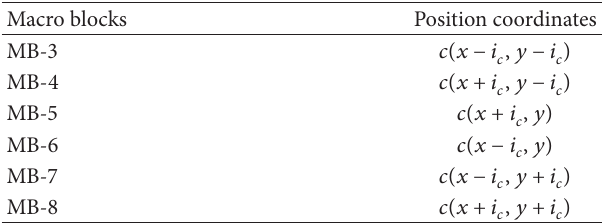
Table 3: Position coordinates of vertex macroblock with